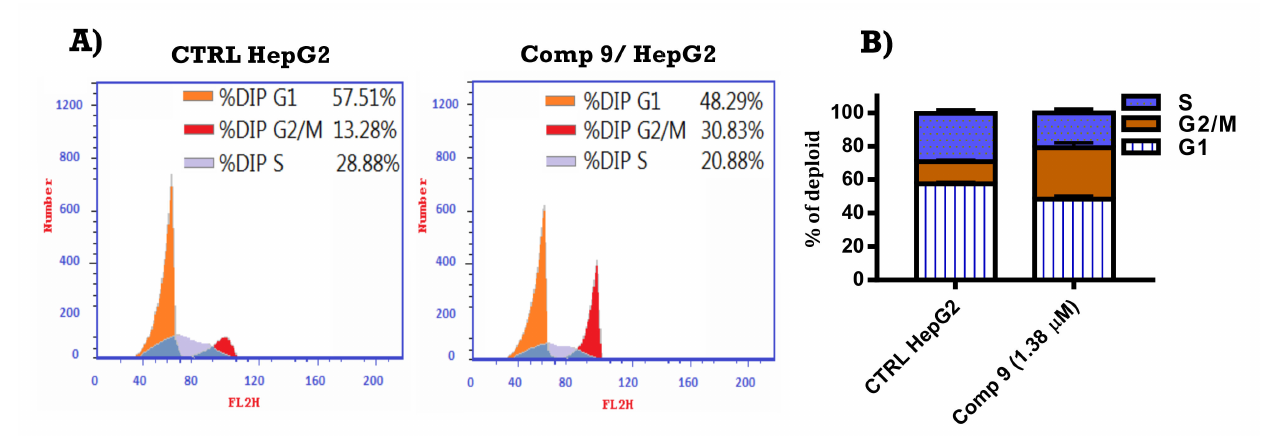
Figure 3. Compound 9 induces G2/M phase disturbance in HepG2 cells. ( A ) HepG2 cells were treated with 1.38 µ M of compound 9 for 48 h. Cell apoptosis was quantized by PI and FACS analysis using image-based cytometry. ( B ) The percentage of cells in different phases was quantized.